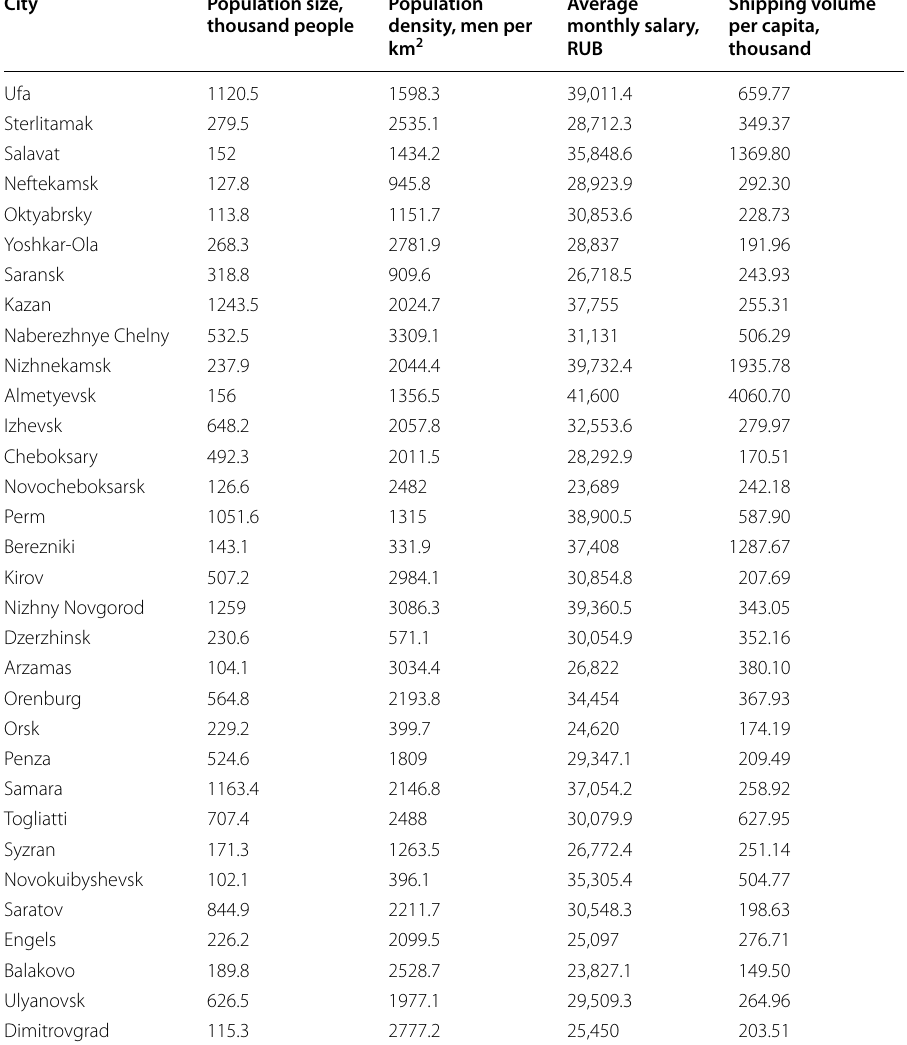
Table 1 Parameters being analyzed in the cities of the Volga Federal District of Russia in 2017 (Russian regions. Main social and economic parameters of cities. 2018 // Federal Service of State Statistics [Electronic resource] URL:http:// www. gks. ru/ free_ doc/ doc_ 2018/ region/ reg- gor18.